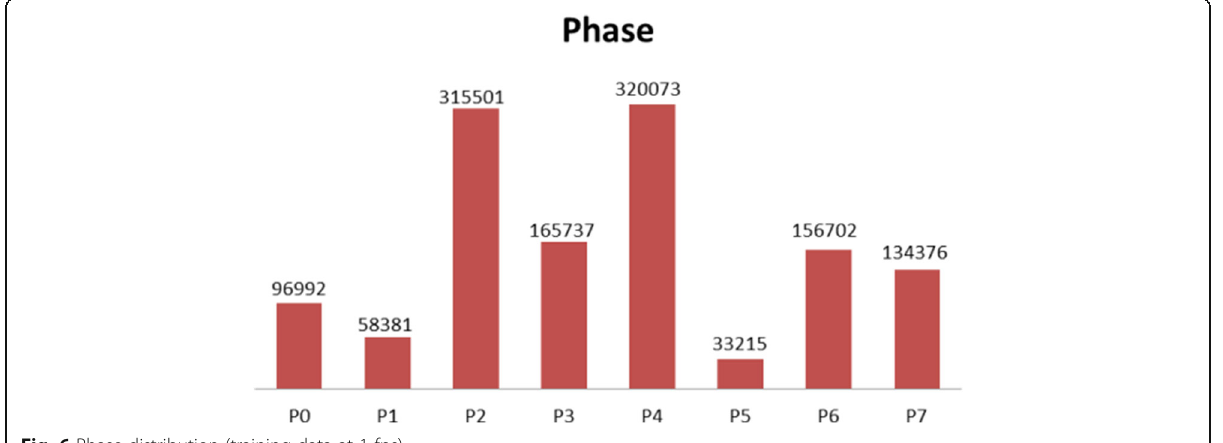
Fig. 6 Phase distribution (training data at 1 fps)